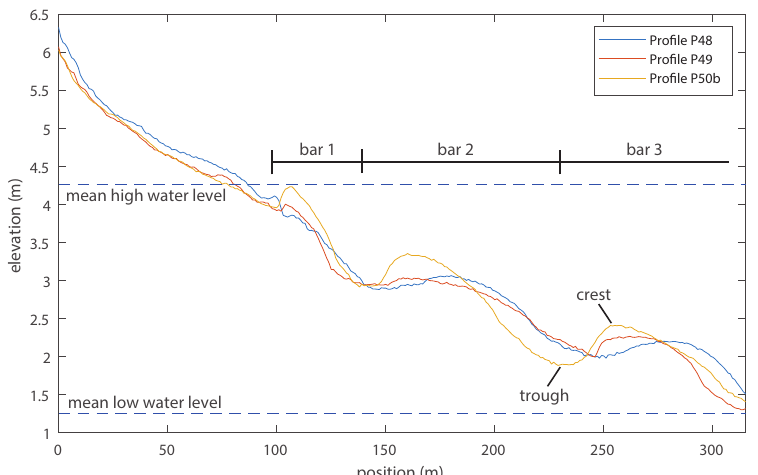
Figure 2. An example of three cross-shore Coastal Division profiles (out of the five) sampled at the same date, emphasizing the presence of sand bars over all profiles as well as the variability between